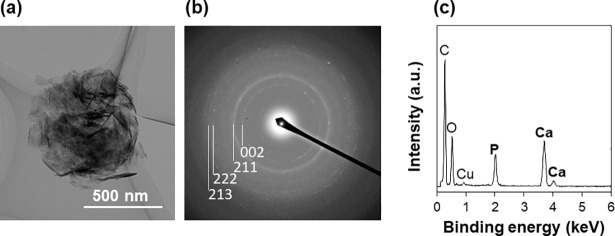
TEM image (a), electron diffraction pattern (b), and TEM-EDX spectrum (c) of the precipitate scraped from the surface of the LAB-processed (2 W/cm2, 30 min) PEEK substrate. Rings observed in (b) were indexed to hydroxyapatite (JCPDS No. 09–0432).